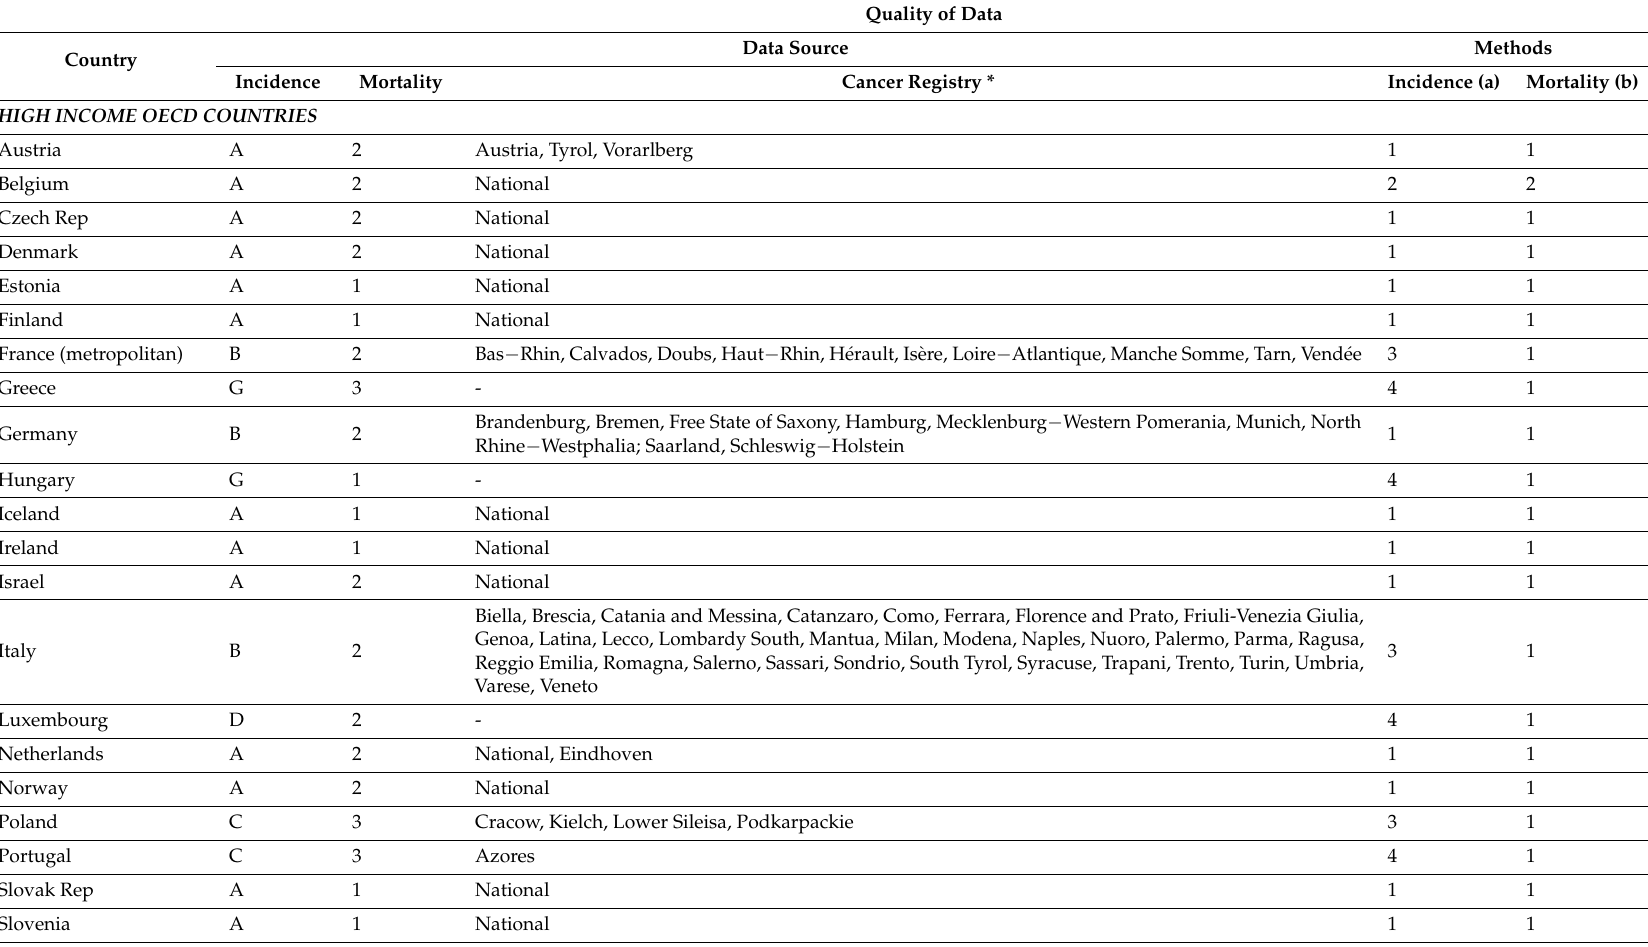
Table 4. Epidemiological data quality for the 53 WHO European area